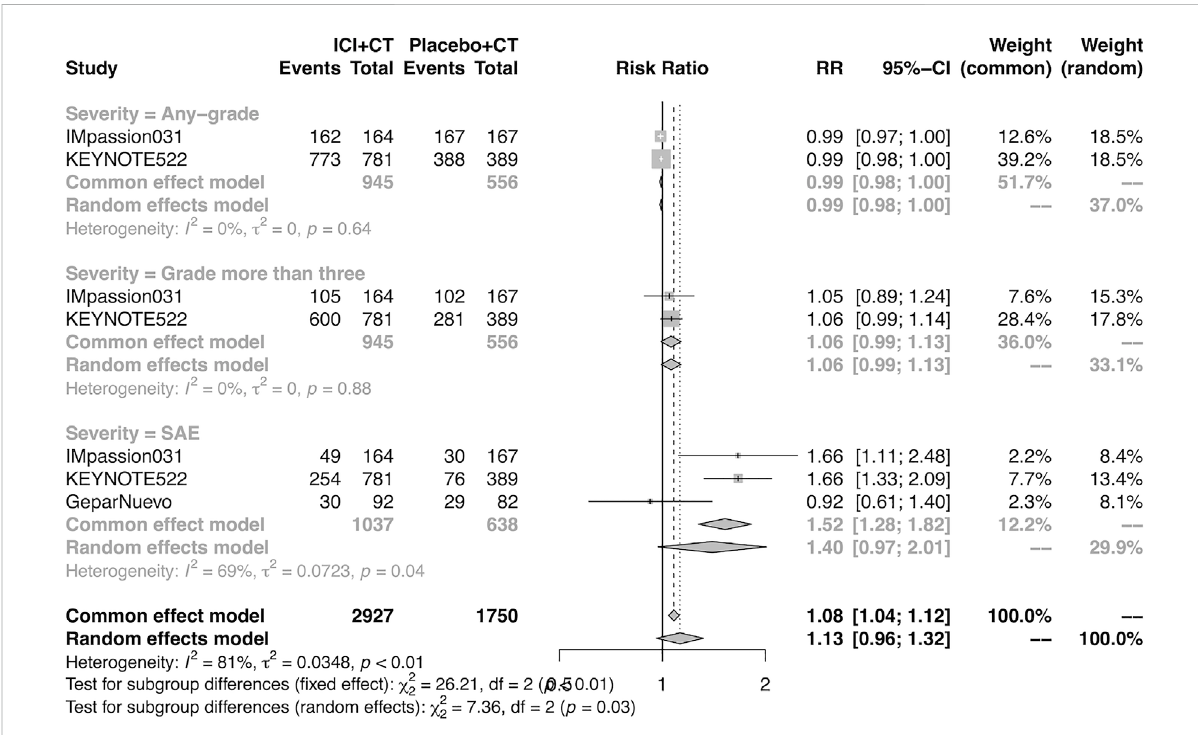
FIGURE 7 Pooled AEs in neoadjuvant therapy clinical trials. SAEs, severe adverse events; RR, relative risk; 95% CI, 95% con fi dence interval; ICIs, immune checkpoint inhibitors; CT,